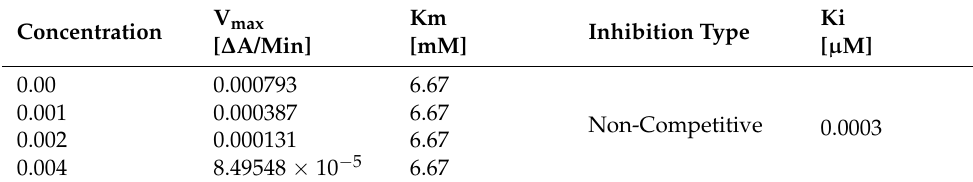
Table 2. Urea activity with different concentrations of 4i